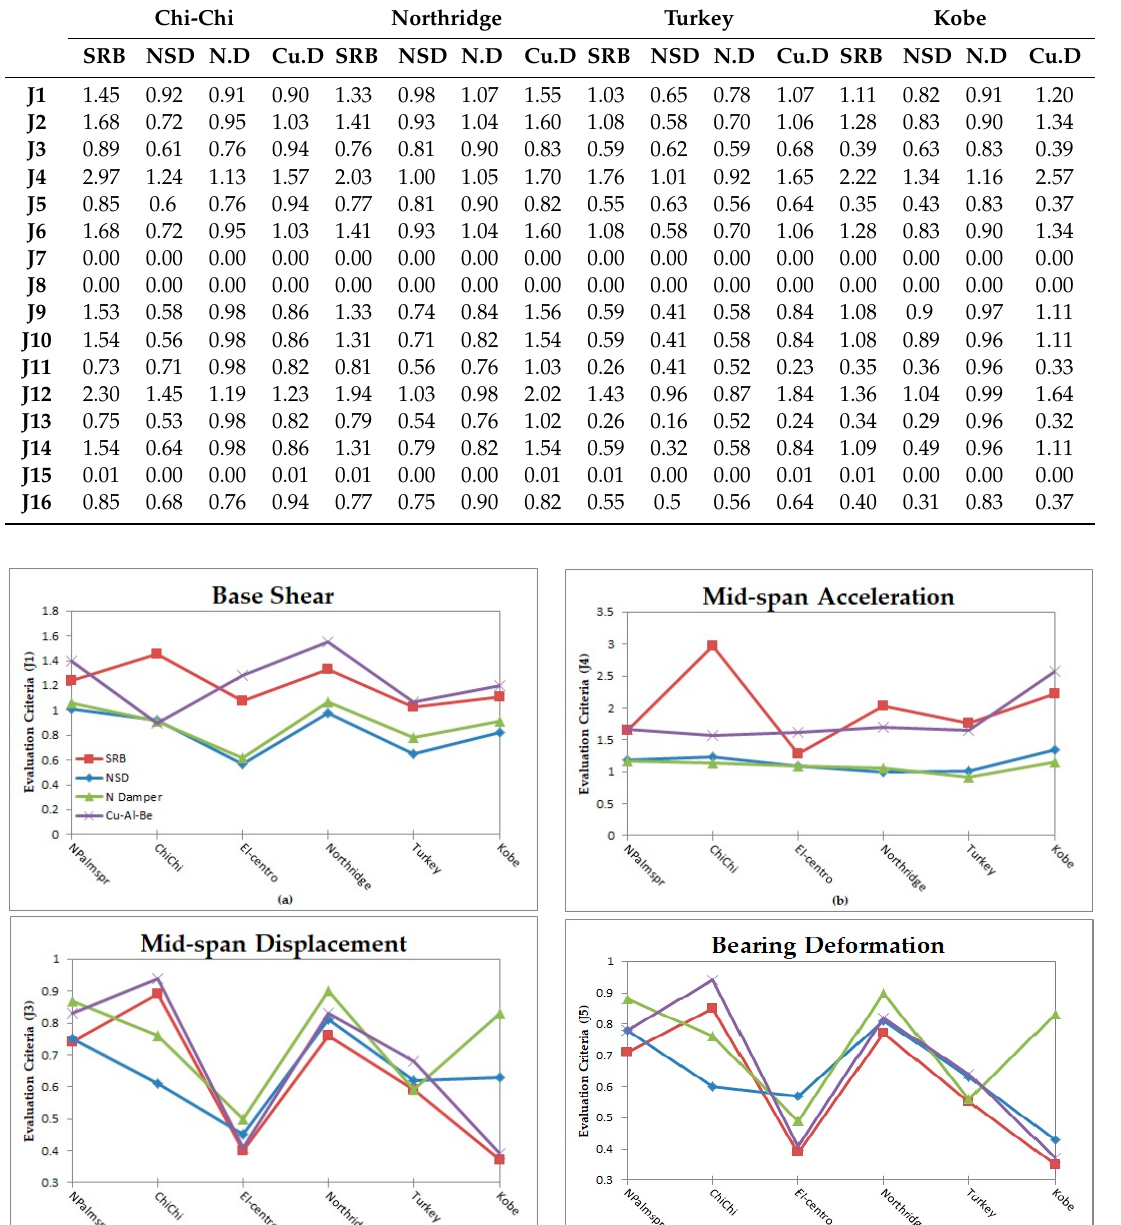
Table 7. Nonlinear dynamic analysis results of the benchmark bridge equipped with SMA isolators under near-field earthquake records.